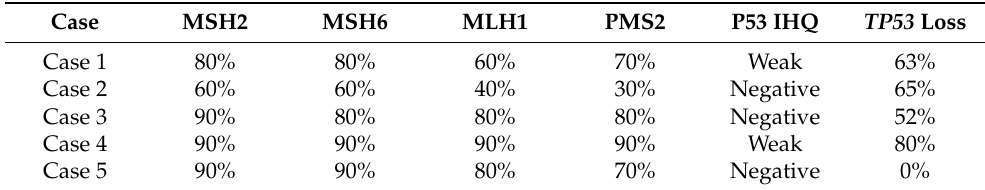
Table 2. Immunohistochemical results of MMR, p53 immunohistochemistry (IHQ) and TP53 deletion in fluorescence in situ hybridization (FISH).